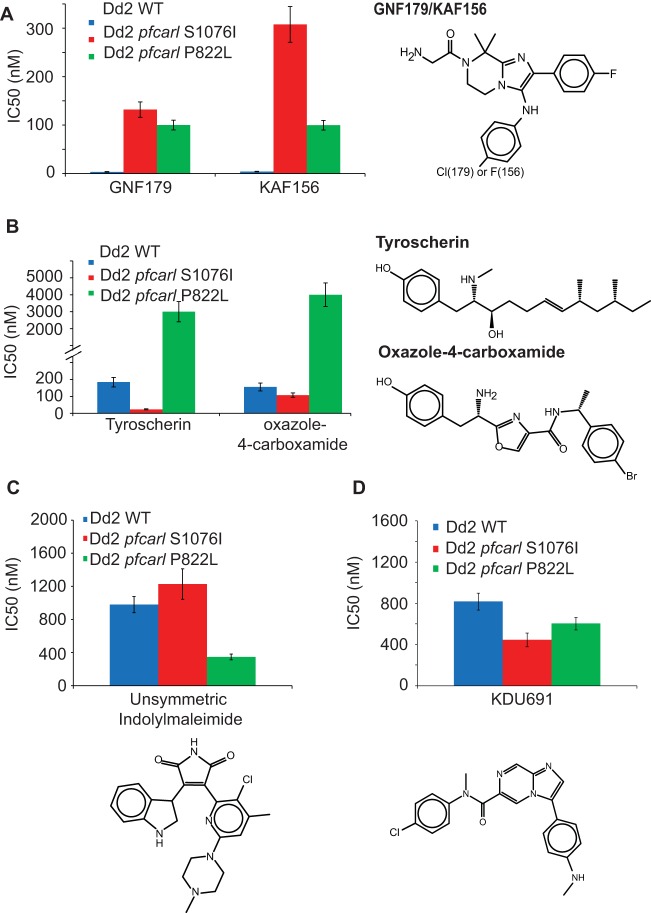
Mutations in pfcarl convey resistance against scaffolds unrelated to imidazolopiperazines. Data show differences between the pfcarl P822L and S1076I amino acid changes in the activity of KAF156 and GNF179 (A), tyroscherin and an oxazole-4-carboxymide (B), and an asymmetric (unsymmetric) indolymaleimide (C) and KDU691 (D). IC50s, generated via 72-h SYBR green assay, are reported as means ± SE with n = 3.